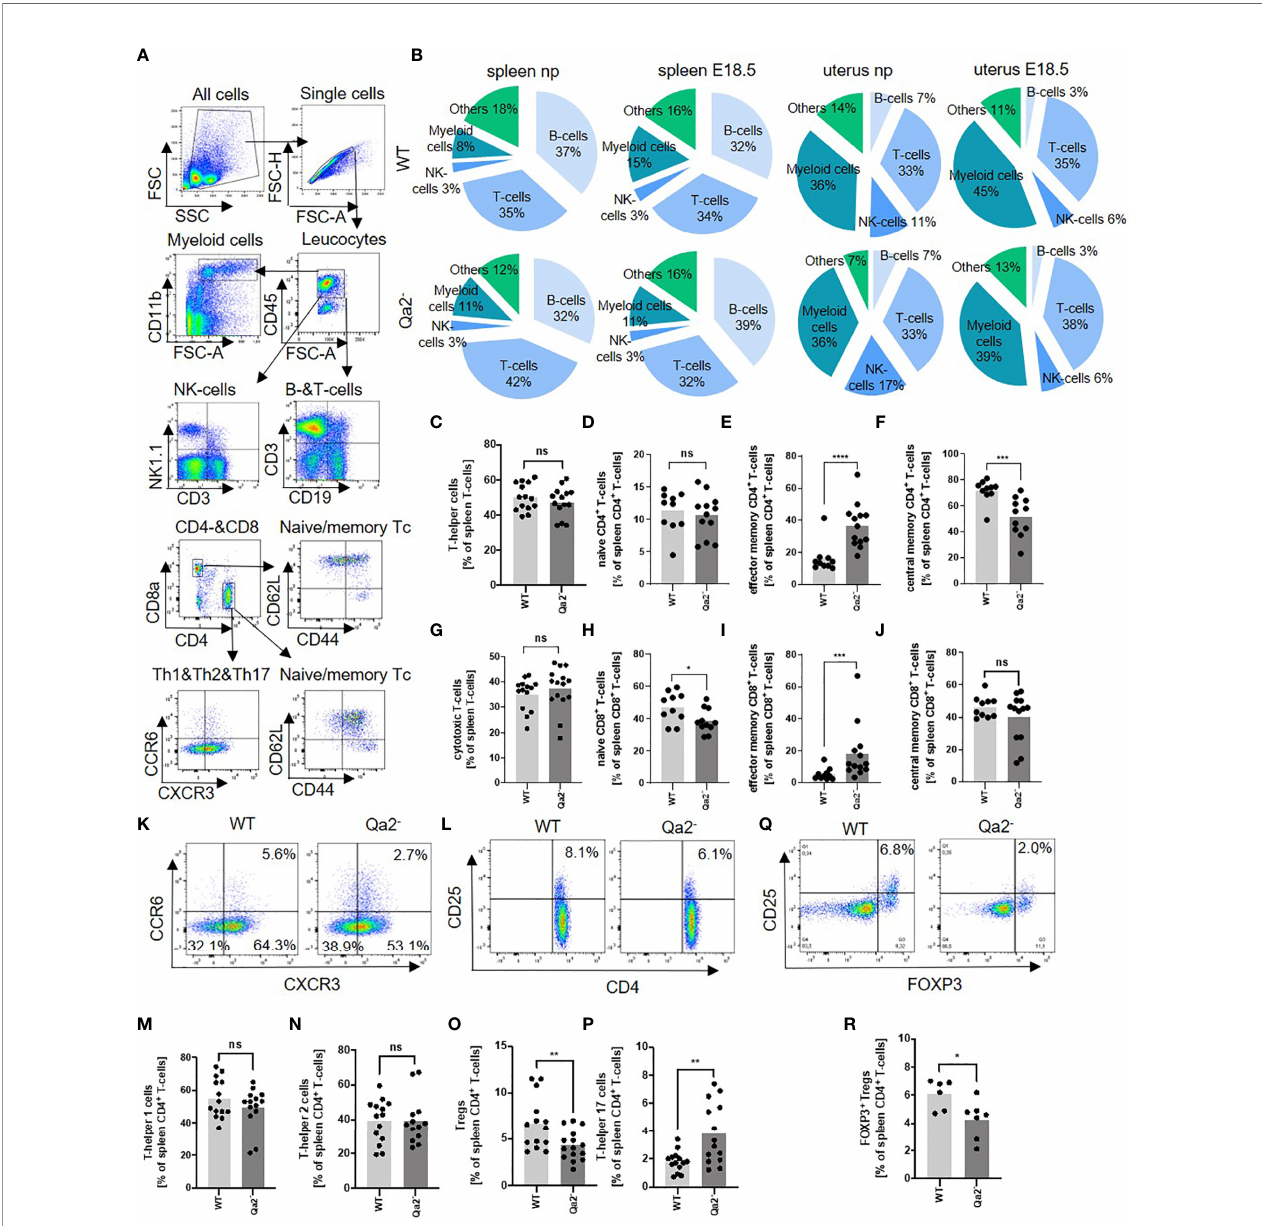
FIGURE 2 | Immune cell composition in WT and Qa-2 de fi cient animals. Wildtype (WT) and Qa-2 de fi cient mice (Qa2 - ) were term-bred and the day when a vaginal plug was detected was de fi ned as day E0.5. Spleen cells were analyzed by fl ow cytometry. (A) Gating strategy for gating immune cell subpopulations. (B) Proportions of the different cell types in spleens and uteri of non-pregnant (np) and E18.5 pregnant (E18.5) WT (upper diagrams, n=14-17 for np and n=16 for E18.5) and Qa-2 - animals (lower diagrams, n=16-21 for npand n=12-13 for E18.5). (C – J) Percentages of all T-helper cells (C) , naïve T-helper cells (D) , effector memory T-helper cells (E) , central memory T-helper cells (F) , all cytotoxic T-cells (G) , naïve cytotoxic T-cells (H) , effector memory cytotoxic T-cells (I) and central memory cytotoxic T-cells (J) from all spleen leucocytes in WT (n=10-14) and Qa-2 - animals (n=11-15). (K) Representative pseudocolor plots for CXCR3 versus CCR6 showing the populations of T-helper 1 cells (lower right quadrant), T-helper 2 cells (lower left quadrant) and T-helper 17 cells (upper left quadrant) in spleen leucocytes. Cells were pre-gated on CD45, CD3 and CD4. (L) Representative pseudocolor plots for CD4 versus CD25 showing the population of T reg cells in spleen leucocytes in the upper right quadrant. Cells were pre-gated on CD45 and CD3. (M-P) Percentages of all T-helper 1 cells (M) , T-helper 2 cells (N) , T reg cells (O) and T-helper 17 cells (P) from all spleen leucocytes in WT (n=10-14) and Qa-2 - animals (n=11-15). (Q) Representative pseudocolor plots for Foxp3 versus CD25 showing the population of Foxp3+ T reg cells in spleen leucocytes in the upper right quadrant. Cells were pre-gated on CD45, CD3 and CD4. (R) Percentages of Foxp3 T reg cells from all spleen leucocytes in WT (n=6) and Qa-2 - animals (n=7). Each symbol represents an individual animal and the mean is indicated. Light grey bars represent WT animals and dark grey bars represent Qa-2 - animals. ****p < 0.0001; ***p < 0.001; **p < 0.01; *p < 0.05; ns, not signi fi cant. Mann-Whitney